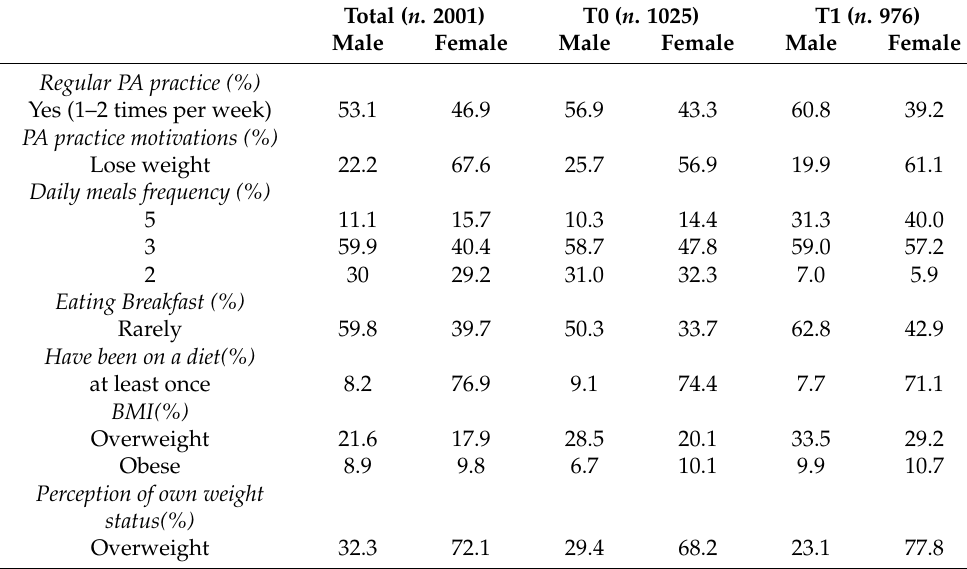
Table 2. Statistically significant changes of physical activity, eating behaviours, BMI, and perception of own body weight by